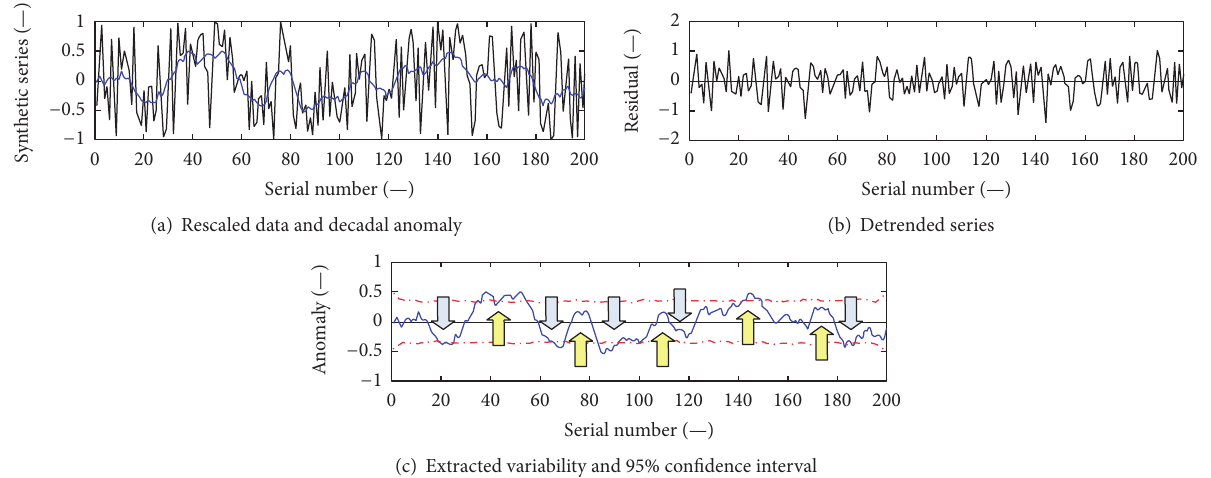
Figure 10: NAIM results for (a) the decomposition of synthetic series, (b) detrending of the series, and (c) significance of the decadal anomalies in the